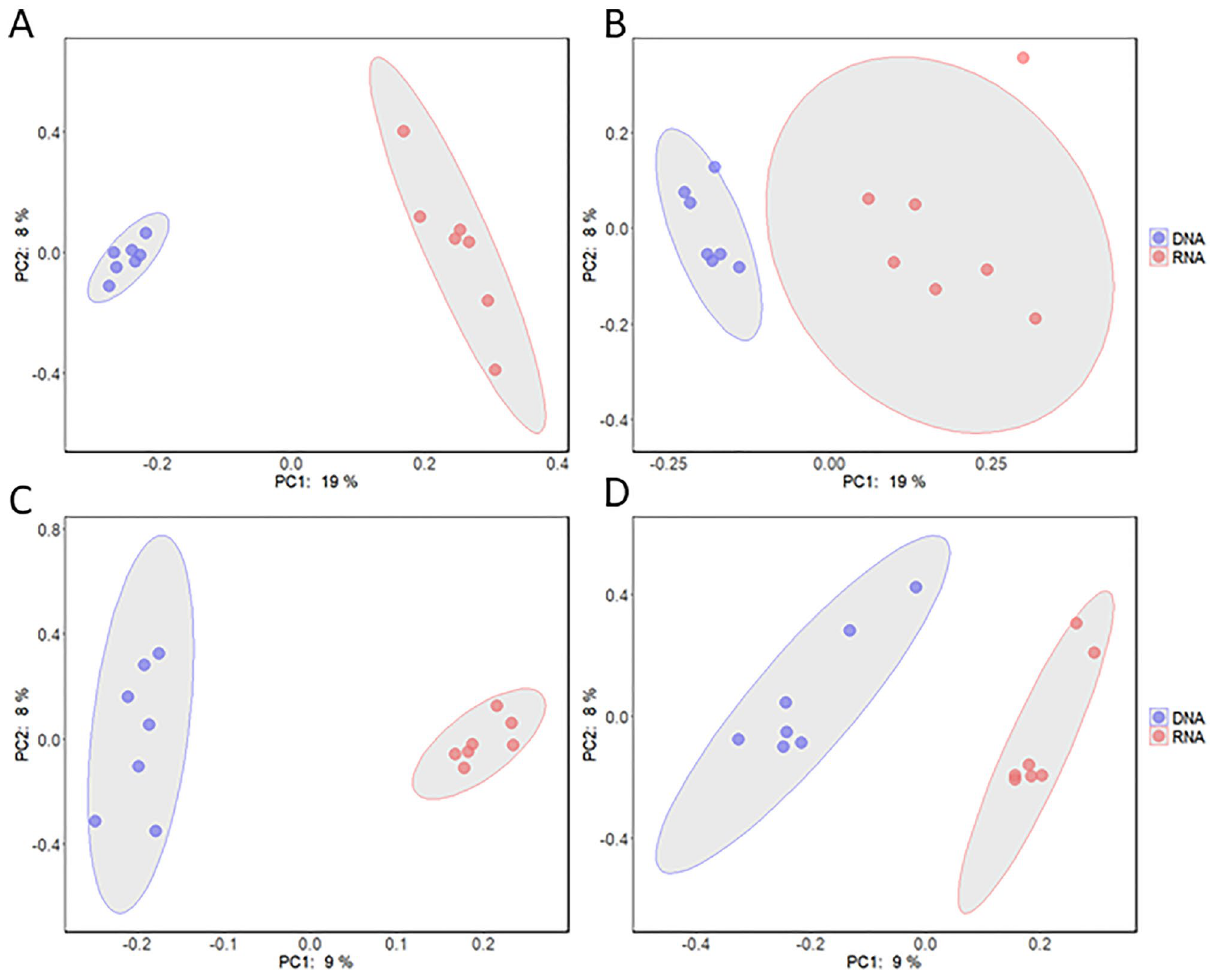
Figure 5. Beta diversity PCOA plots for DNA (teal) vs. RNA (orange) metabarcoding templates for the 18S gene ( A and B ) and for the COI gene ( C and D ). Bray-Curtis diversity is reported in A and C, and Jaccard’s Distance is reported in B and D. Confidence ellipses were calculated at 95%. All plots show significant differences at p < 0.002 in diversity between DNA and RNA template groups using a PERMANOVA analysis (n =